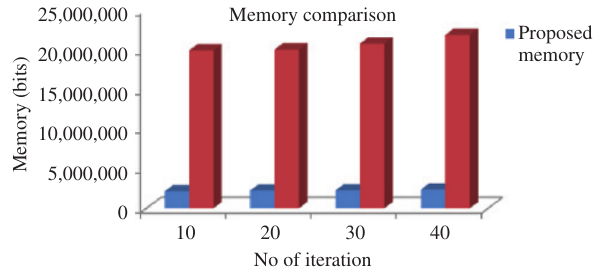
Figure 12: Comparative Analysis of